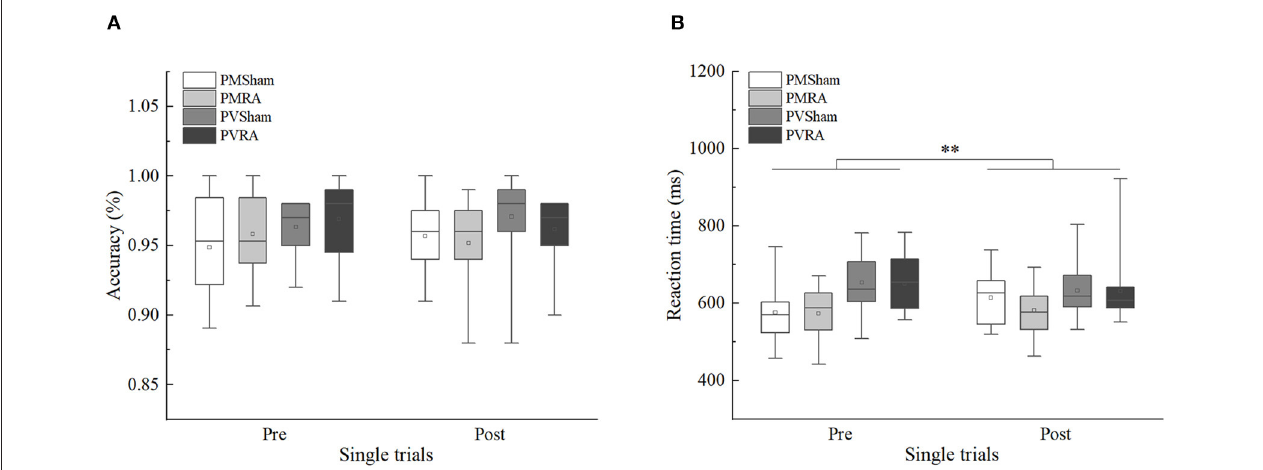
FIGURE 2 | Single trials accuracy and reaction time of sham and right anode (RA) tDCS groups in pre-tDCS and post-tDCS. (A) Single trials accuracy. (B) Single trials reaction time. PMSham, single trials of parity/magnitude task in sham tDCS group; PMRA, single trials of parity/magnitude task in RA tDCS group; PVSham, single trials of parity/vowel-consonant task in sham tDCS group; PVRA, single trials of parity/vowel-consonant task in RA tDCS group. ** p <